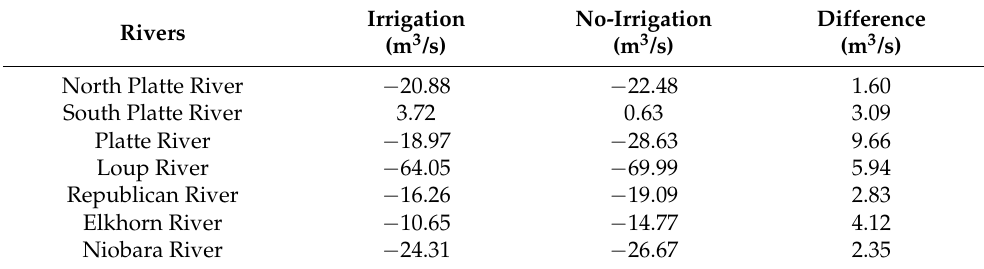
Figure 10. Auto-Irr estimated differences in the long term (1982–2008) mean annual surface–groundwater exchange between irrigated and non-irrigated scenarios. Table 3. Long term (1982–2008) mean annual surface–groundwater exchange in major rivers of the NHP, where negative values indicate groundwater